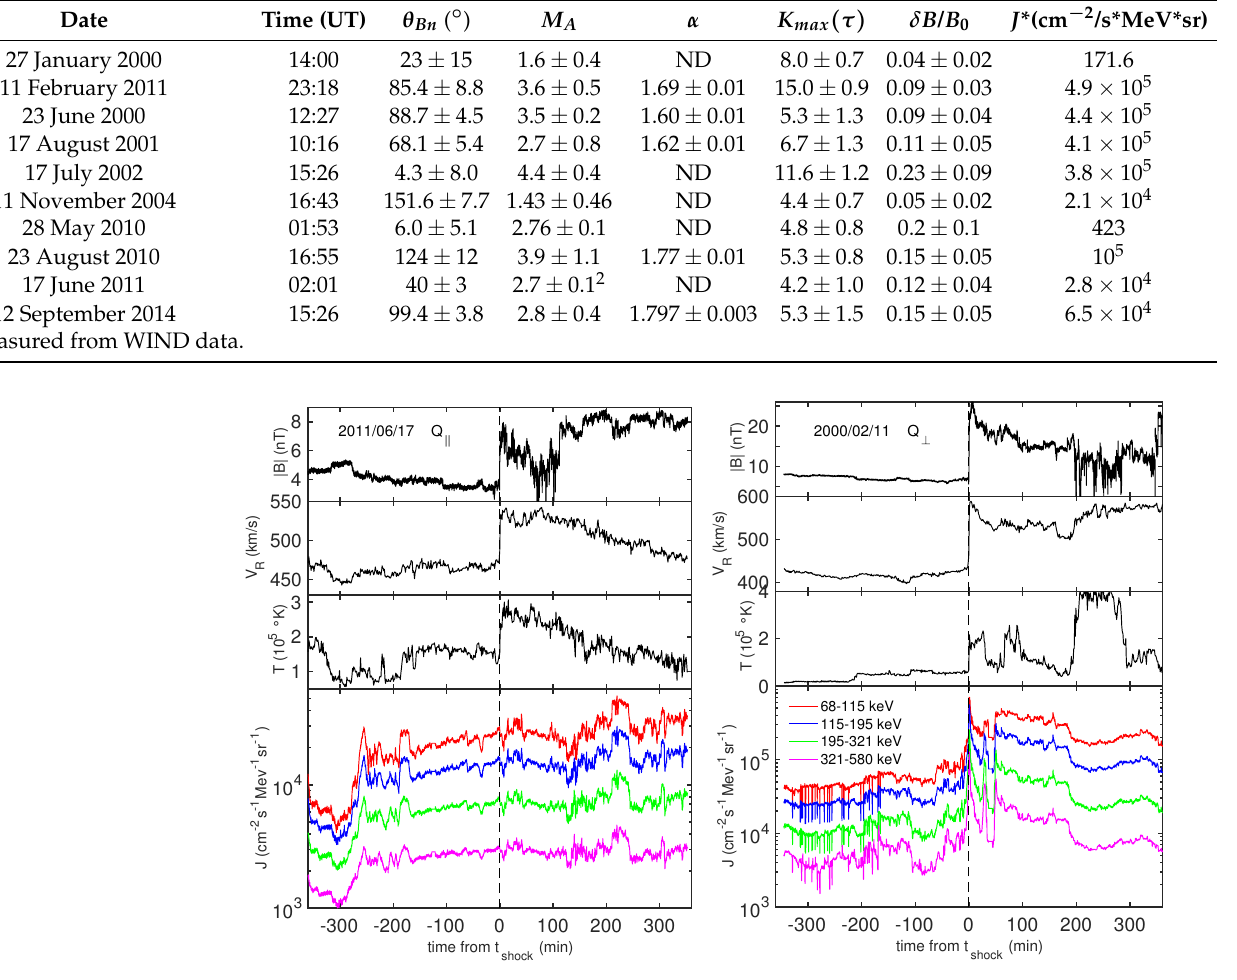
Figure 1. Two satellite shock crossings in quasi–parallel ( left panels ) and in quasi–perpendicular configuration ( right panels ). From top to bottom: the magnetic field intensity from the ACE/MAG instrument at a resolution of 1 vec/s; the radial component of the solar wind bulk speed and the plasma temperature from the ACE/SWEPAM experiment at 64 s resolution; and the ion fluxes in four energy channels (as indicated in the legend in the right bottom panel) from the ACE/EPAM instrument at a resolution of 12 s, as a function of the distance from the shock time (vertical dashed lines). Notice that far downstream of the 11 February 2011 event (at about 200 min from the shock), a hot (and low density) portion of the solar wind plasma occurs, also associated to larger fluctuations in | B | , though this is not actually related to the shock